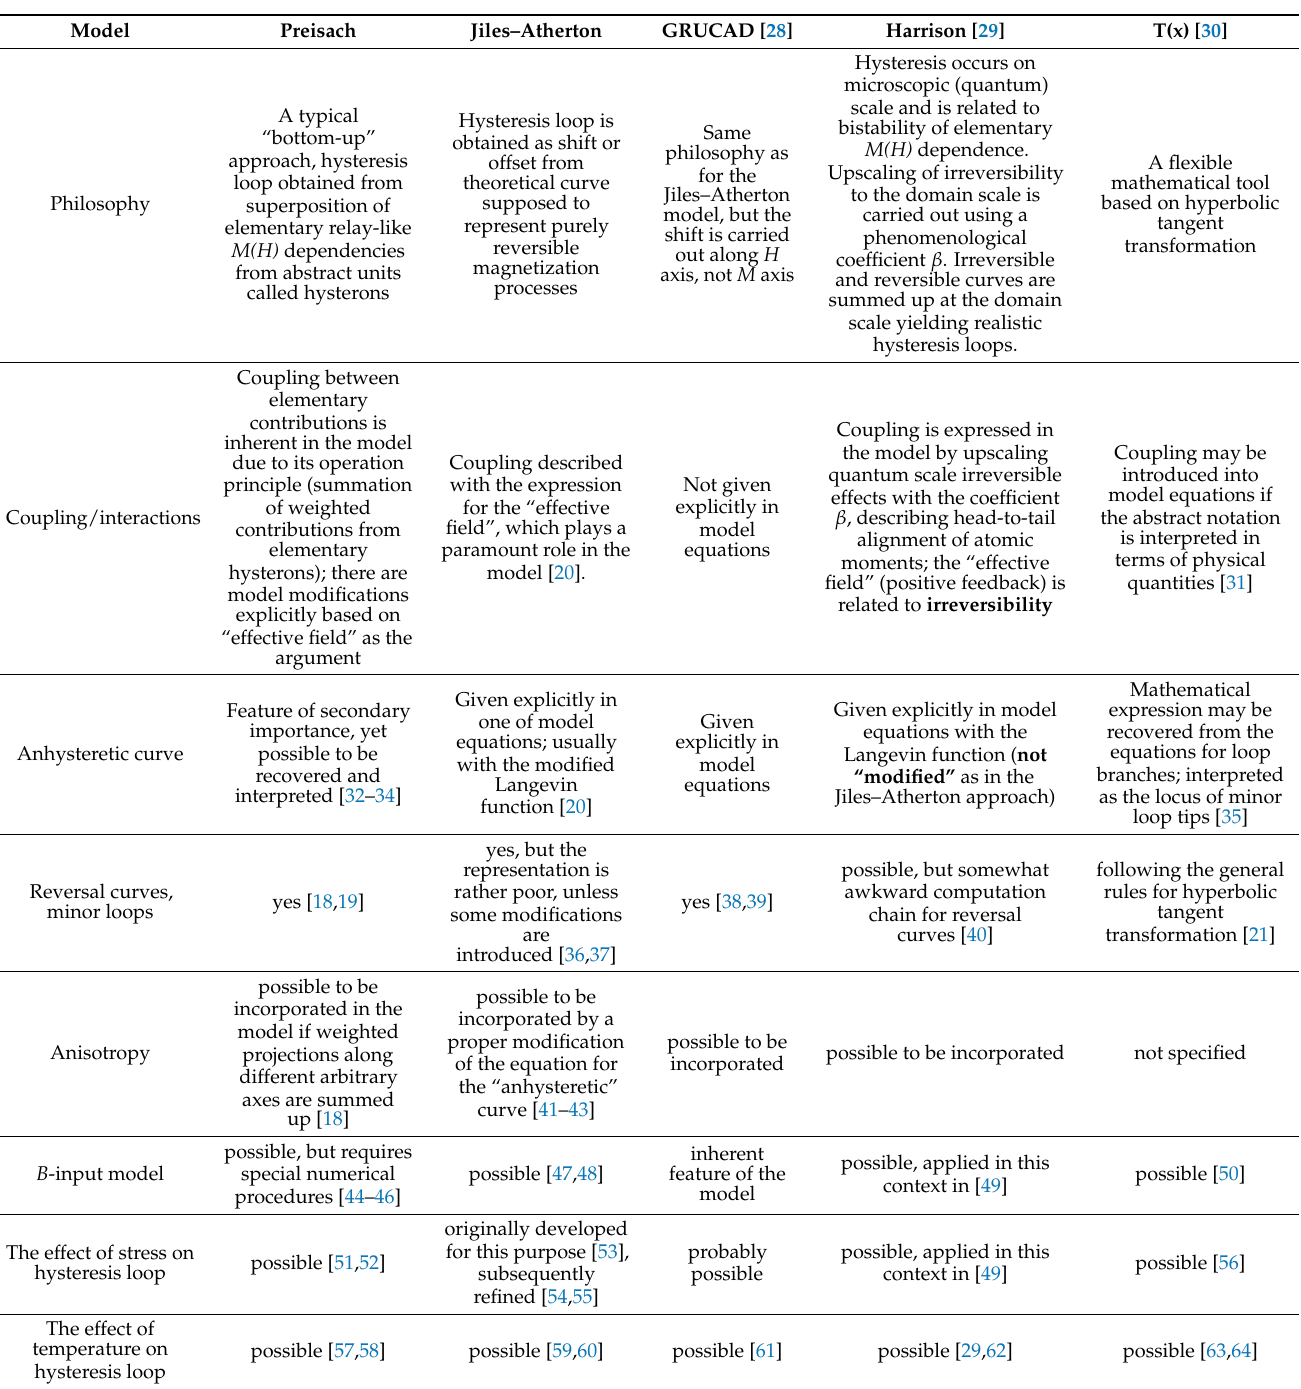
Table 1. A comparison of several hysteresis